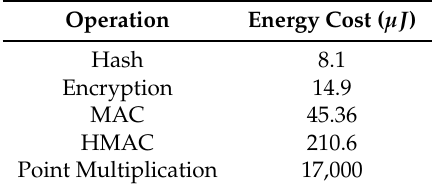
Table 7. Computational energy costs of different operations.